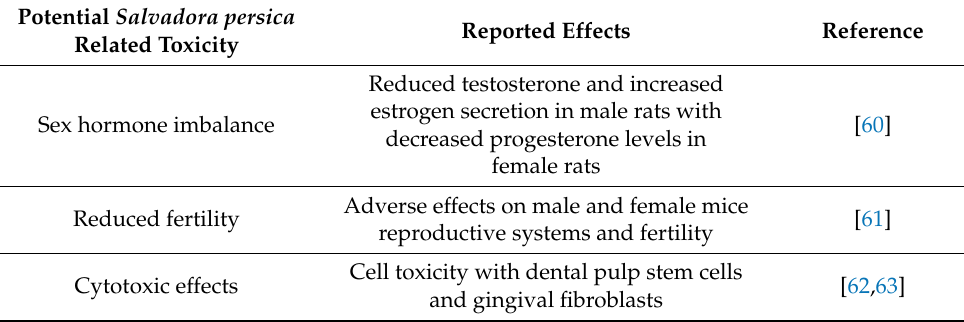
Figure 1. Chemical structures of important phytoconstituents present in the Salvadora persica extract. Table 3. The potential Salvadora persica related toxicity and its reported